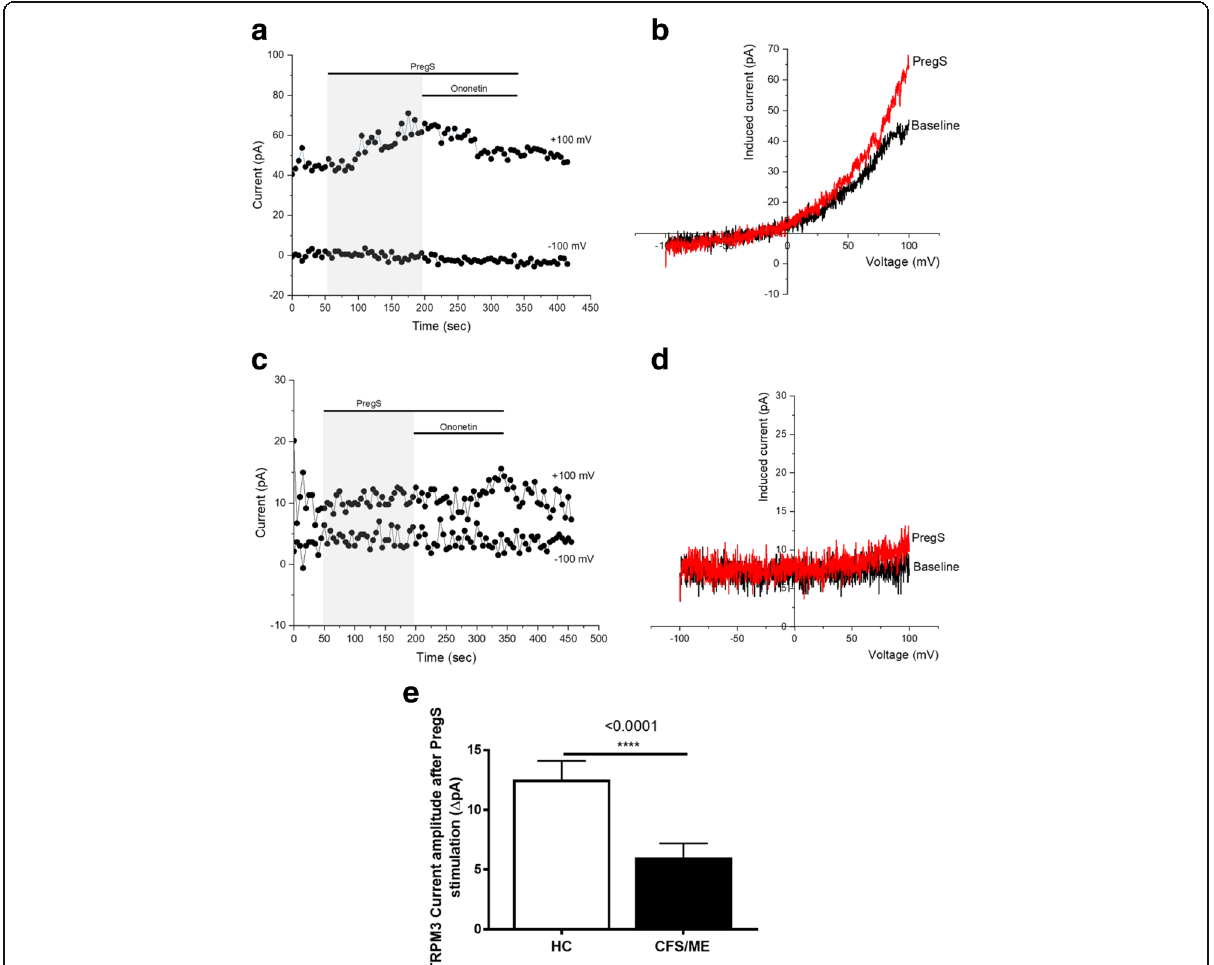
Fig. 2 TRPM3 activity after PregS stimulation. Data were obtained under whole-cell patch clamp conditions. a A representative time-series of current amplitude at + 100 mV and − 100 mV showing the effect of 100 μΜ PregS on ionic currents in isolated NK cells from HC. b I – V before and after PregS stimulation in a cell corresponding with ( a .) . c A representative time-series of current amplitude at + 100 mV and − 100 mV showing the effect of 100 μΜ PregS on ionic currents in isolated NK cells from CFS/ME patients. d. I – V before and after PregS stimulation in a cell as shown in ( c .) . e Bar graphs representing TRPM3 current amplitude at + 100 mV after stimulation with 100 μΜ PregS in CFS/ME patients ( N = 6; n = 33) compared with HC (N = 6; n = 29). Data are represented as mean ± SEM. Abbreviations: CFS/ME, chronic fatigue